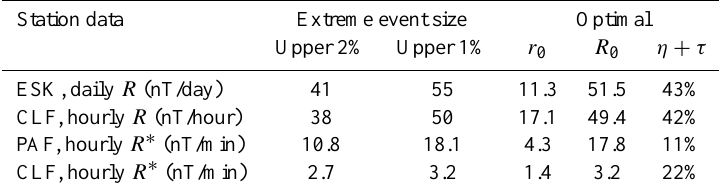
Table 2. Summary of the simplest prediction of R